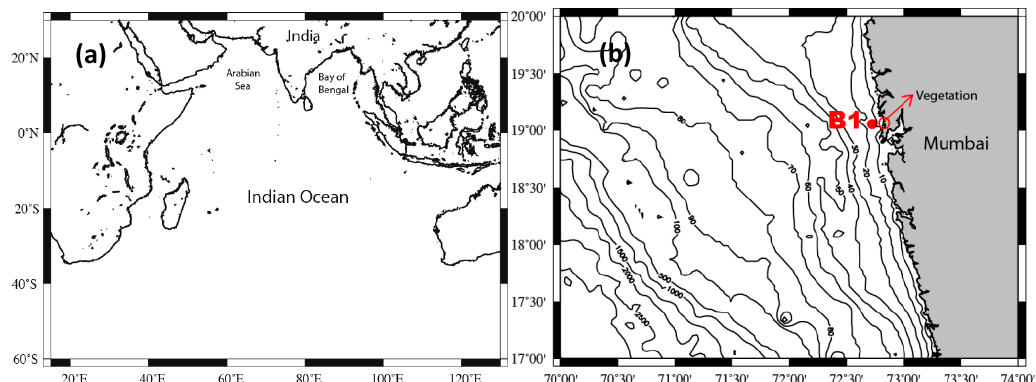
Figure 1. ( a ) Outer domain of the Indian Ocean chosen for modeling; ( b ) inner domain with depth contours off Mumbai, including buoy location.